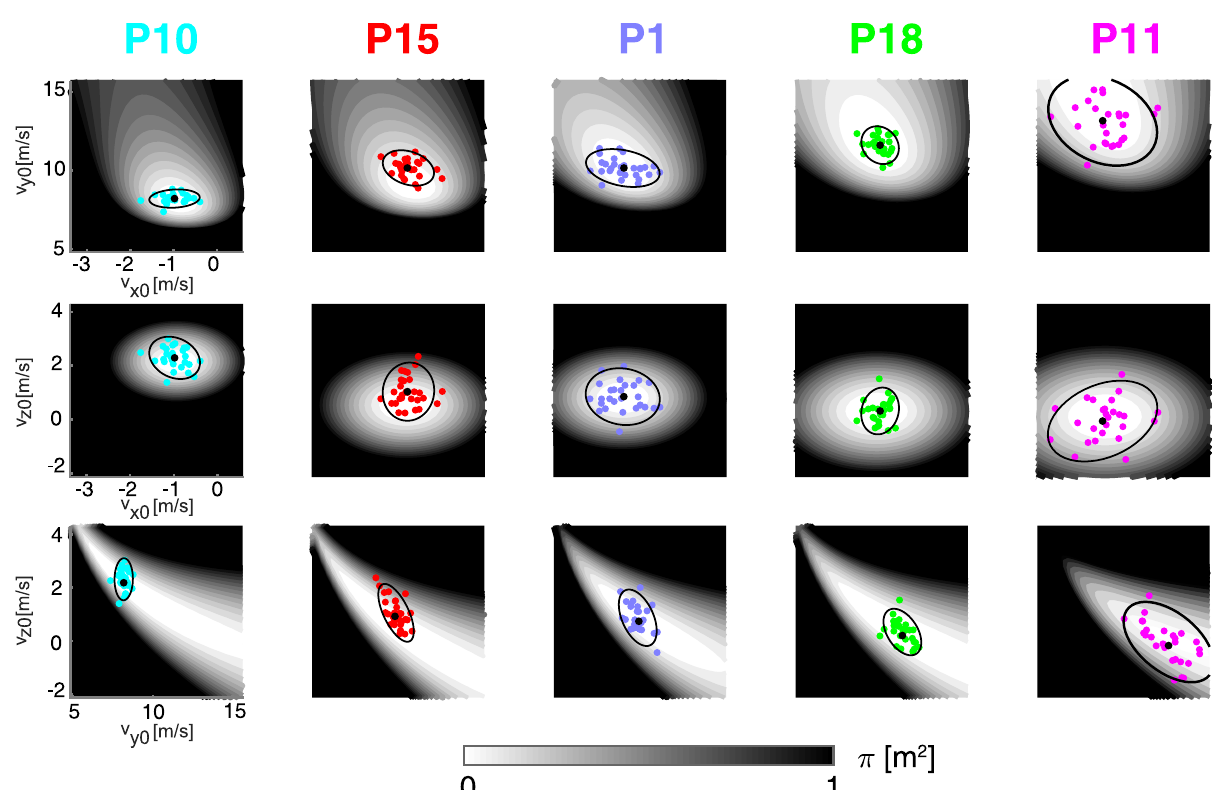
Fig 5. Examples of distribution of release velocity components for five representative participants (target T1). Each row illustrates a pairs of release (cid:0) v , v (cid:0) v , v (cid:0) v ). Colored circles represent release parameters of individual throws. Black circles and ellipses velocity components ( v x 0 y 0 x 0 z 0 y 0 z 0 represent mean and covariance (95% c.l.) of each parameter distribution. The gray-level shading of the contours indicates the local score, as a function of the release parameters. Note that in each row, the range of horizontal and vertical axes are the same for all participants, and the different shapes of the score across participant, reflect individual differences in the average action (mean position and velocity vectors at release). The wider the white area around the mean action, the more tolerant the score is to noise. Participants have been sorted from left to right according to their average release speed.